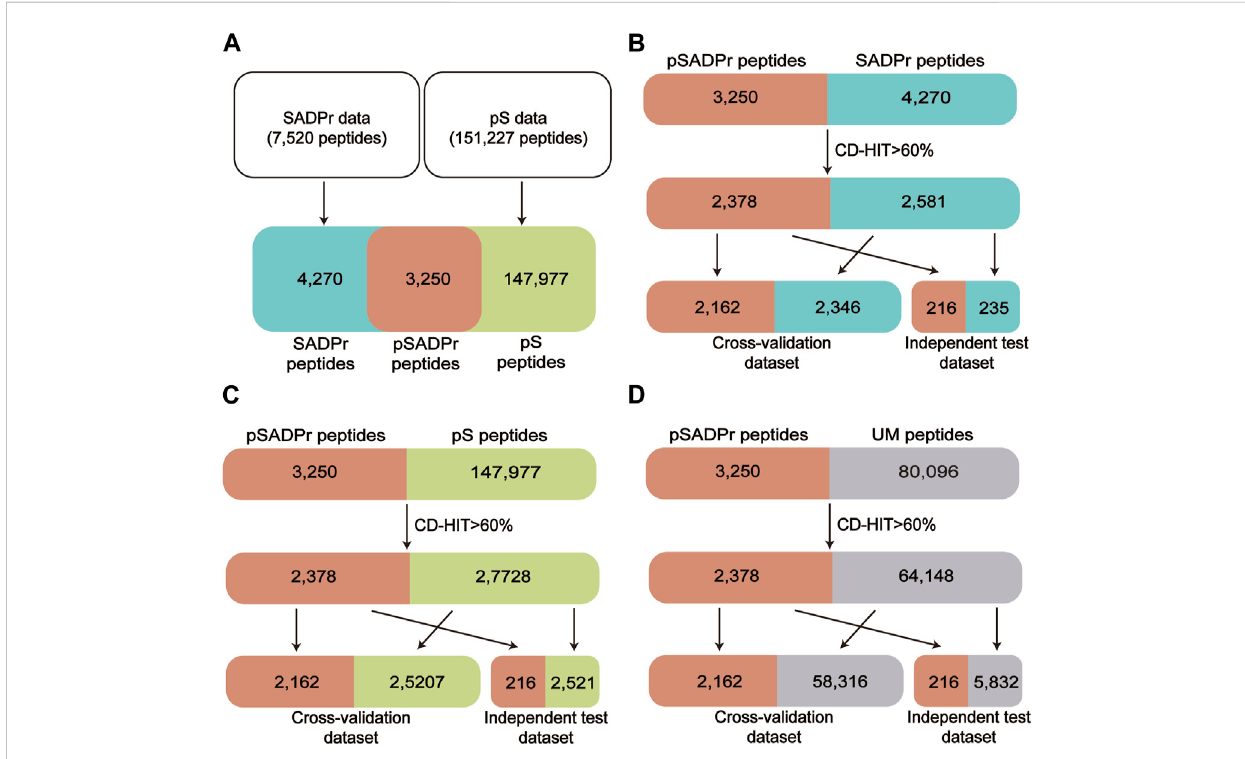
FIGURE 2 Schematic diagram of data collection and preprocessing for human pSADPr datasets. Construction of the pSADPr, pS and SADPr datasets (A) . The construction and preprocessing of the pSADPr-SADPr dataset (B) , the pSADPr-pS dataset (C) and the pSADPr-UM dataset (D) . UM stands for unmodi fi ed